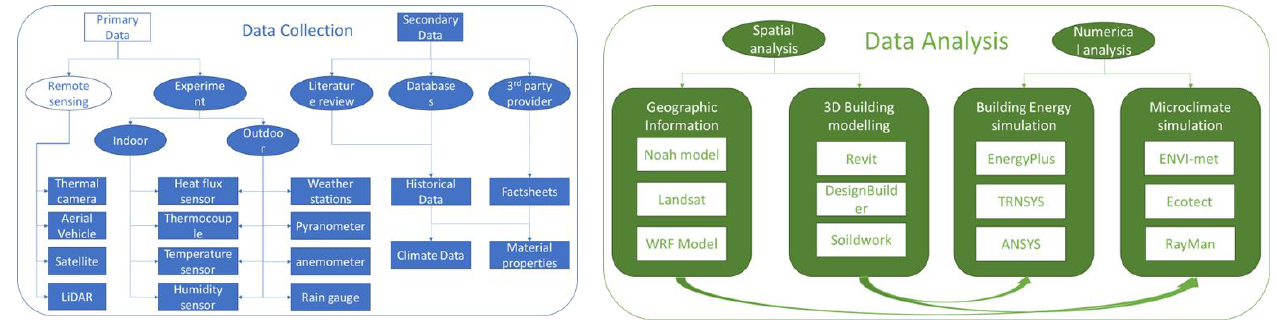
Figure 14. The typical methods and tools for data collection and analysis that were used in the reviewed articles.